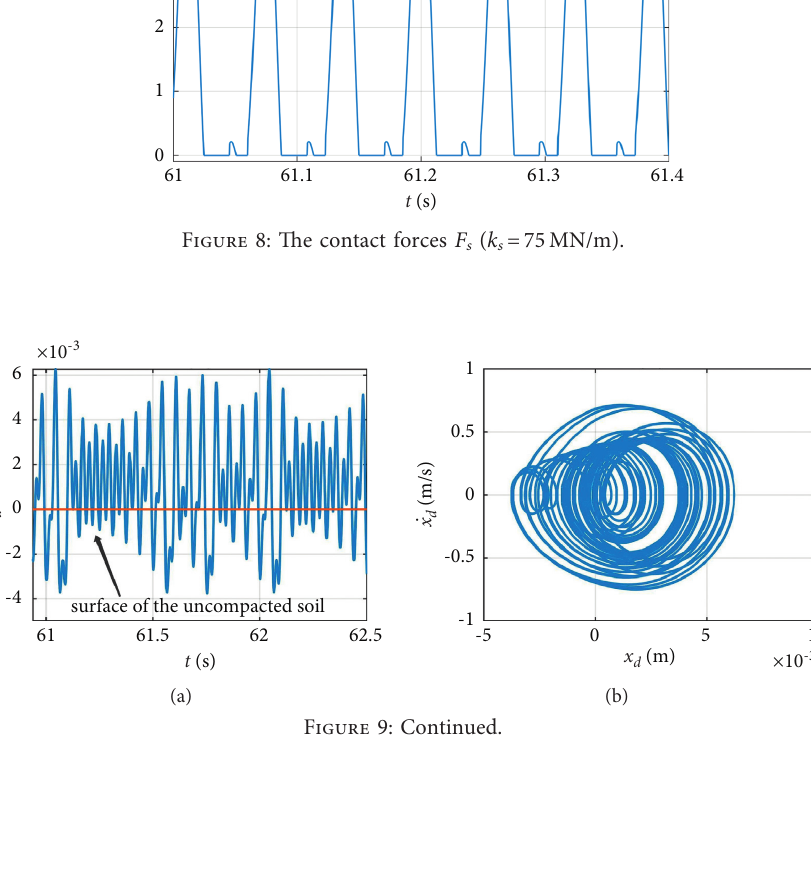
Figure 8: The contact forces F